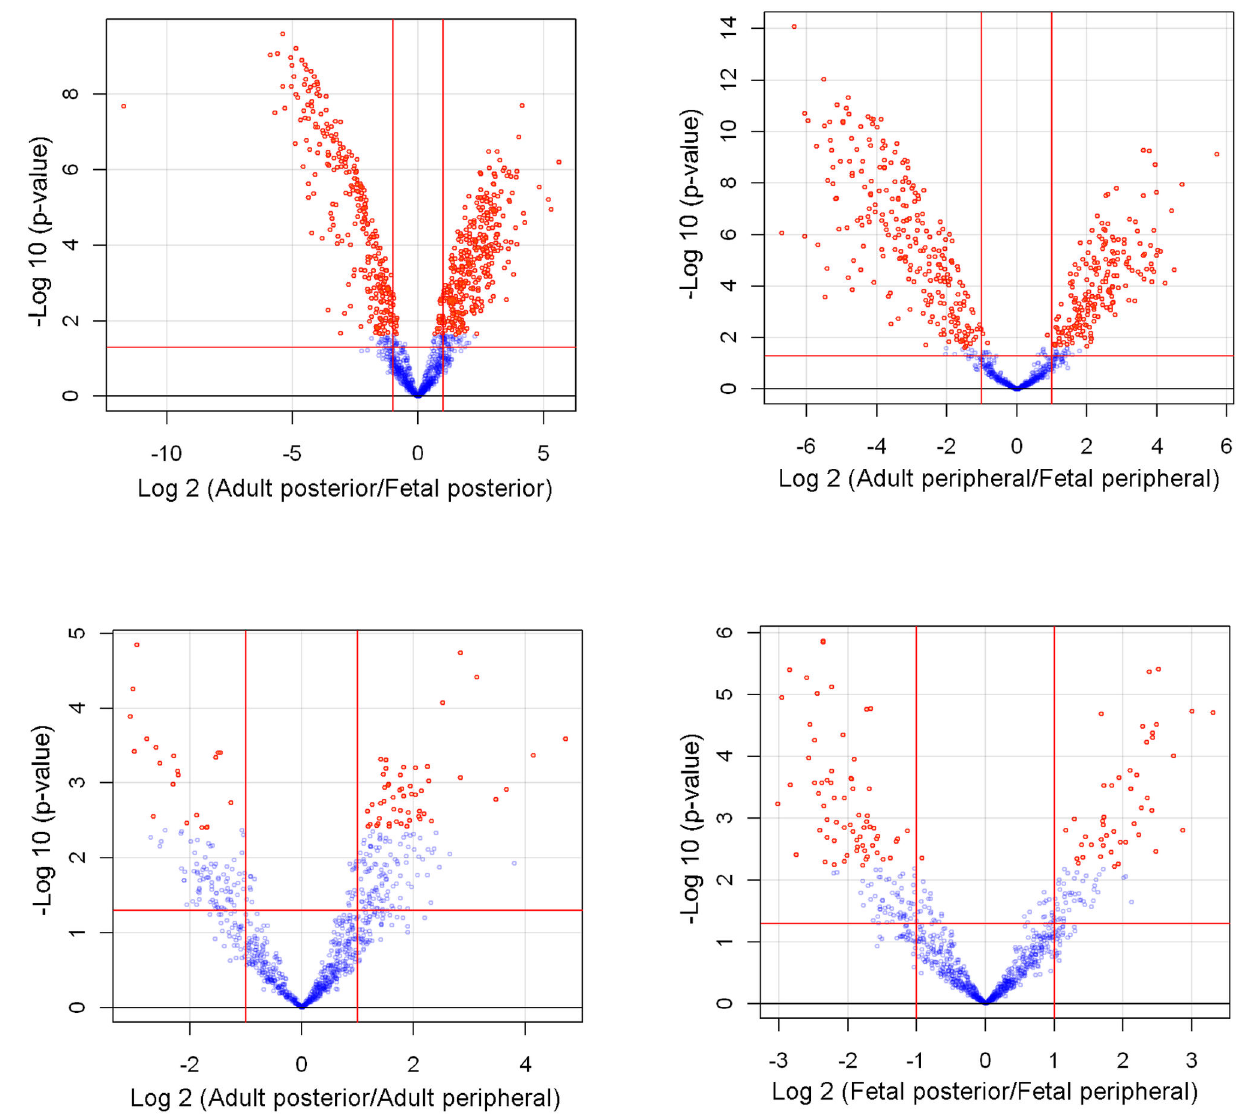
Figure 1. Volcano plots of microarray data showing the relationship between fold change in micro-RNA expression and significance for all pair-wise comparisons (n=4 to 6 per group). The x-axis shows fold change (log the negative log of p-values (higher values indicate greater significances). The two vertical red lines demarcate the area outside of 10 which there is at least a two-fold difference in expression levels between fetal and adult scleras. The single horizontal red line marks the threshold for an unadjusted p-value of 0.05; data points above this line can be considered statistically significant at p-value of 0.05, without correction for multiple testing. Shown in red are data points achieving statistical significance after correction for a 5% false discovery rate (FDR); those not reaching statistical significance are in